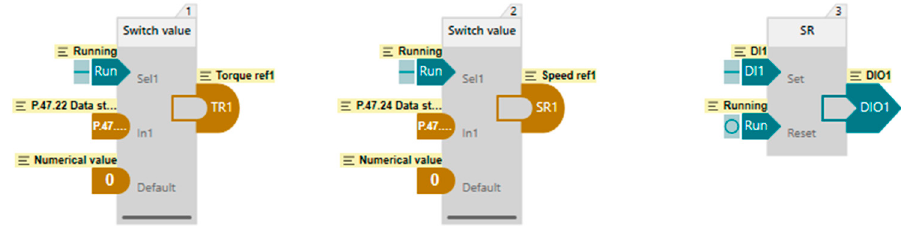
Figure 9. The adaptive program of the DCS converter.